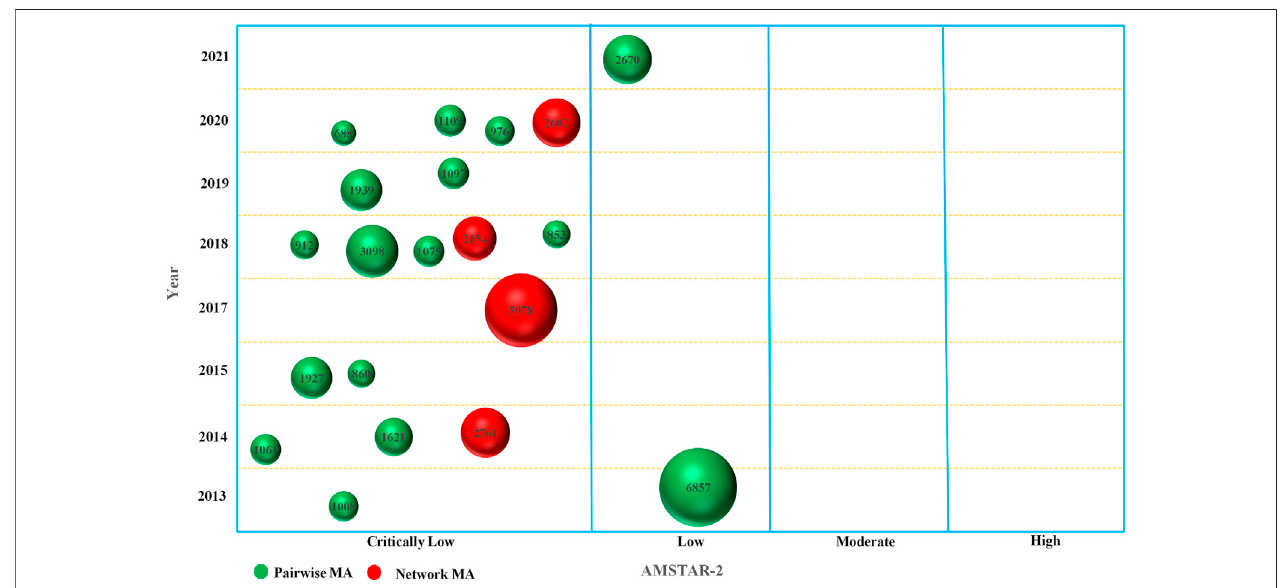
FIGURE 2 | Bubble plot of the overall methodological quality.